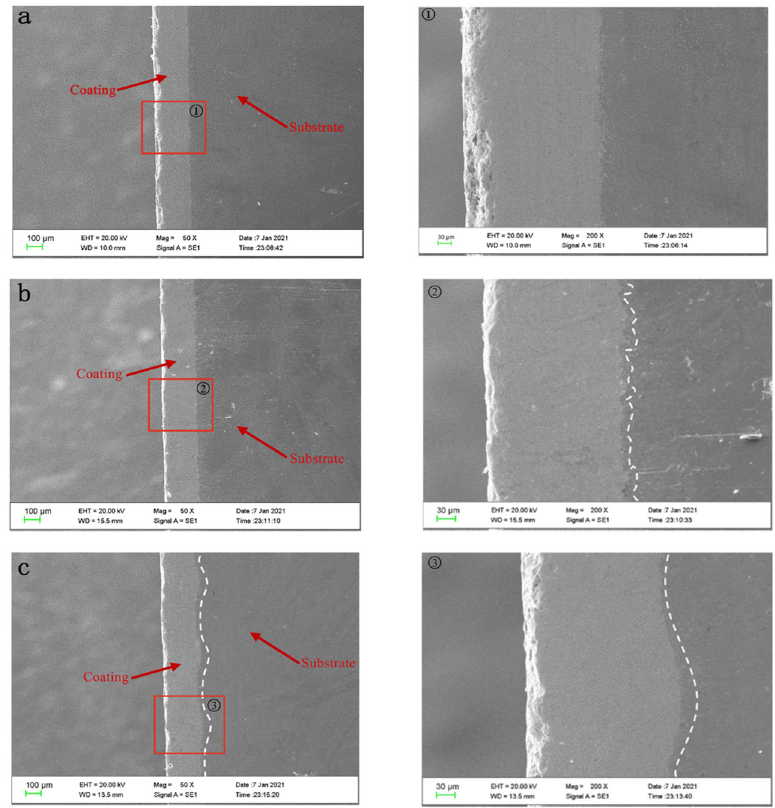
Figure 5. Cross ‐ sectional SEM micrgraph of the coating after different Figure 5. Cross-sectional SEM micrgraph of the coating after different pretreatment processes. pretreatment processes. (a) Coating after polishing pretreatment. (Figure ① is ( a ) Coating after polishing pretreatment. (Figure 1 (cid:13) is a partial enlarged view of the red box in Figure a partial enlarged view of the red box in Figure a) (b) Coating after grit blasting a) ( b ) Coating after grit blasting pretreatment. (Figure 2461 is a partial enlarged view of the red box pretreatment. (Figure ② is a partial enlarged view of the red box in Figure b) in Figure b) ( c ) Coating after laser ablation texture pretreatment. (Figure 3 (cid:13) is a partial enlarged view (c) Coating after laser ablation texture pretreatment. (Figure ③ is a partial of the red box in Figure c). enlarged view of the red box in Figure c)